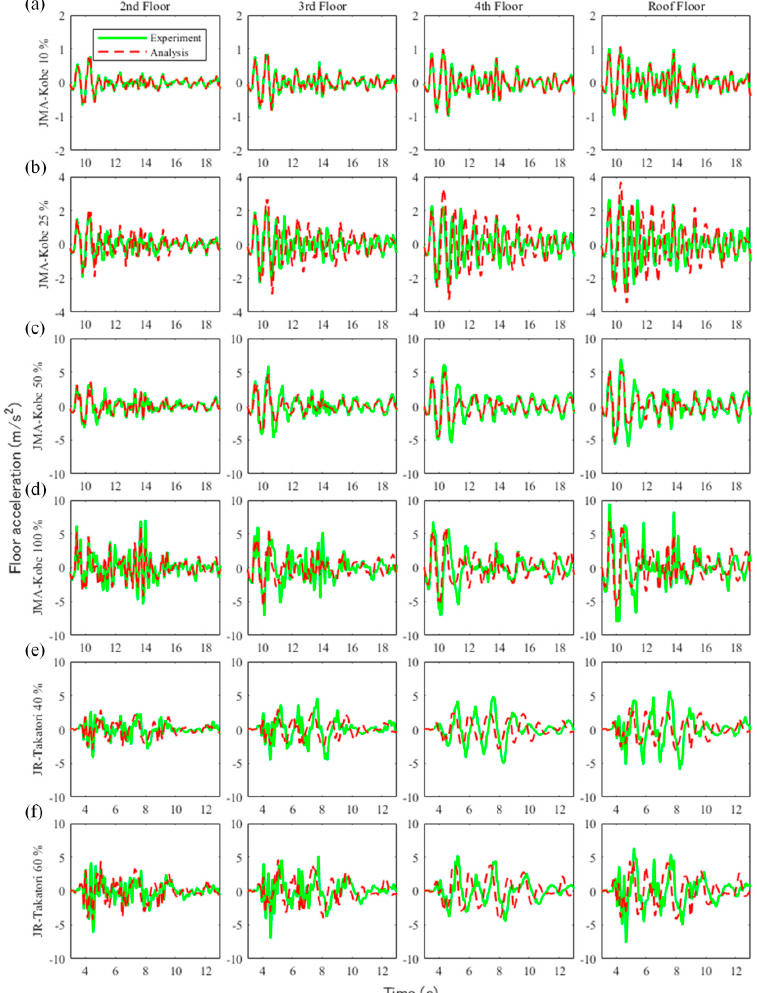
Figure 7. Comparison of the experimental and analyzed floor acceleration results: ( a ) JMA-Kobe 10% amplitude experiment, ( b ) JMA-Kobe 25% amplitude experiment, ( c ) JMA-Kobe 50% amplitude experiment, ( d ) JMA-Kobe 100% amplitude experiment, ( e ) JR-Takatori 40% amplitude experiment, and ( f ) JR-Takatori 60% amplitude